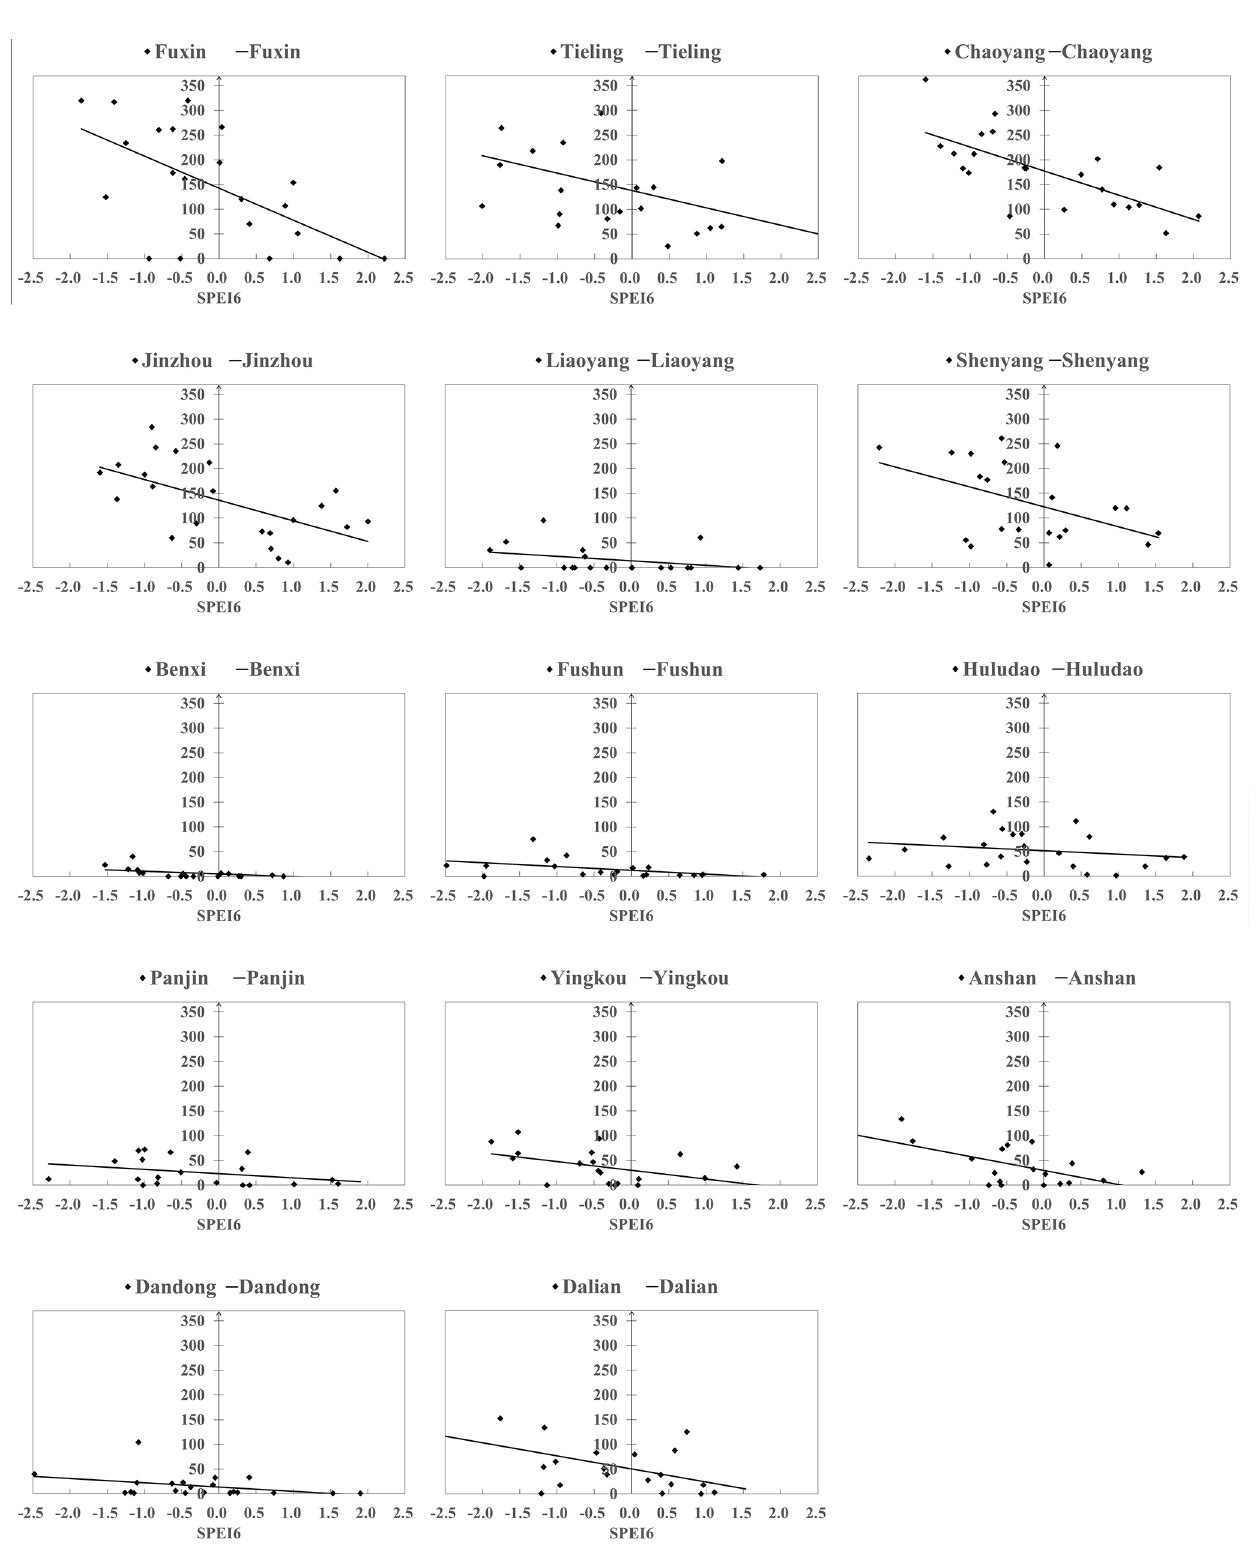
Figure 7. Linear regression results of drought-suffering area (DSA) with the SPEI6 in each of the 14 cities in Liaoning